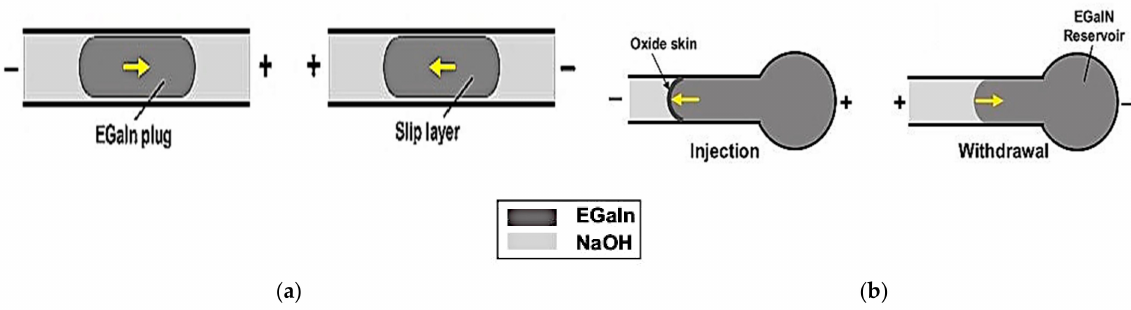
Figure 2. Illustration of the mechanism of ( a ) continuous electrowetting (CEW) and ( b ) electrochemically controlled capillary (ECC)